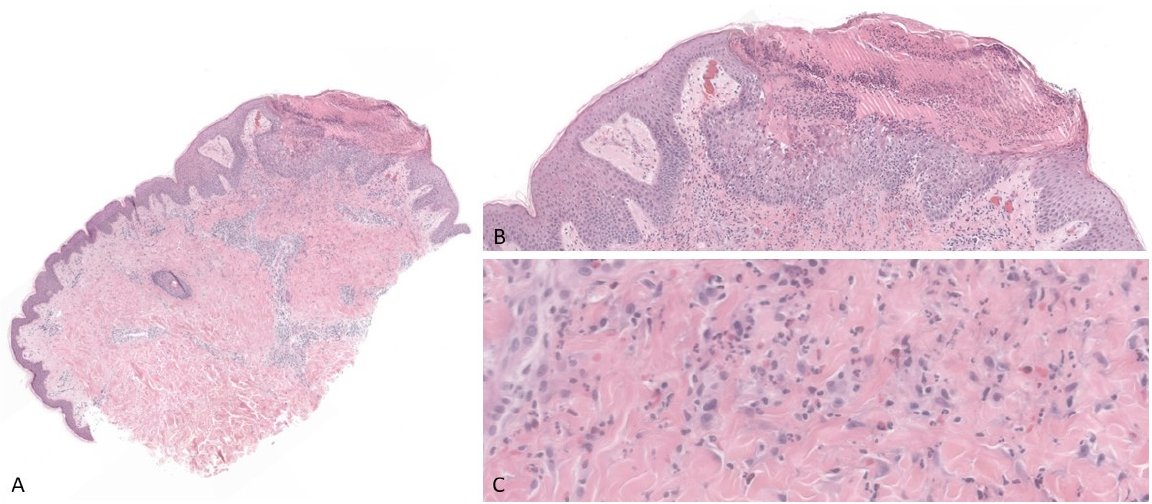
Figure 2. ( A , B ) Histology showing an erosion covered by a crust containing neutrophils and a der- mal inflammatory infiltrate (H&E, original magnification: 1.6× and 6.5×, respectively). ( C ) Inflam- matory infiltrate with neutrophils and numerous eosinophils (H&E, original magnification: